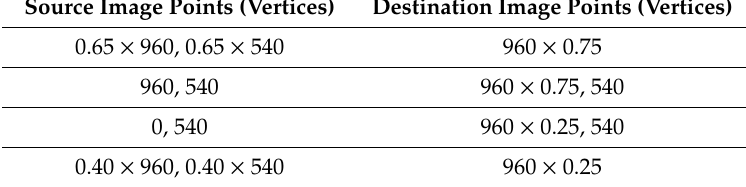
Table 1. The perspective transformation vertices for depth maps. Part of the source image vertices are chosen, and then transformed into another image (destination) that can easily show the rows in straight patterns, which can easily let the model detect the shape of the rows. The width of the image was 960 pixels, and the height was 540 pixels. The ratios times the width or height provide the vertices for the destination images.